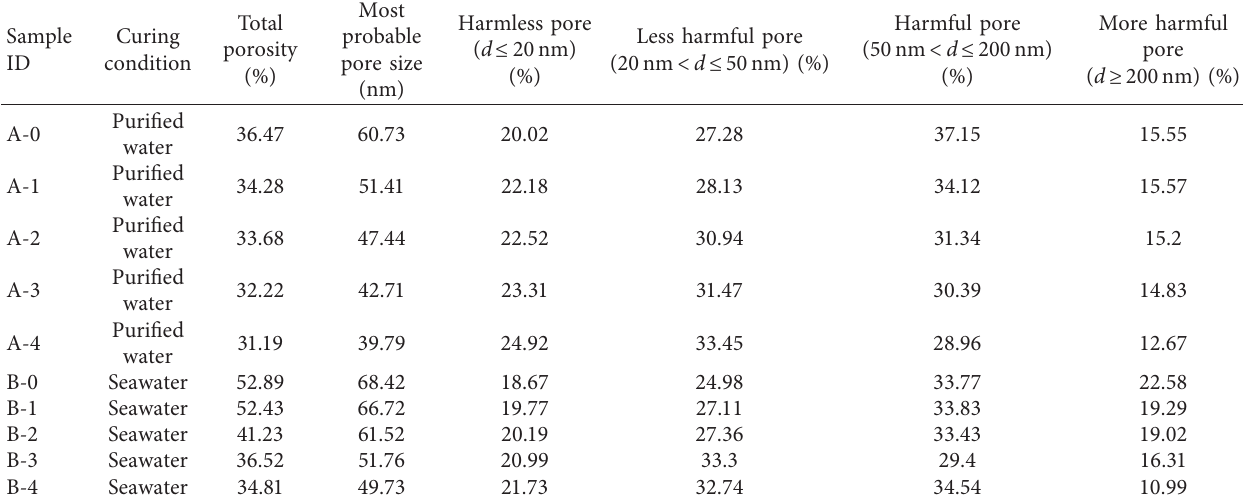
Table 8: The pore characteristics of the cement soil containing ferronickel slag powder at a curing period of 90 days.